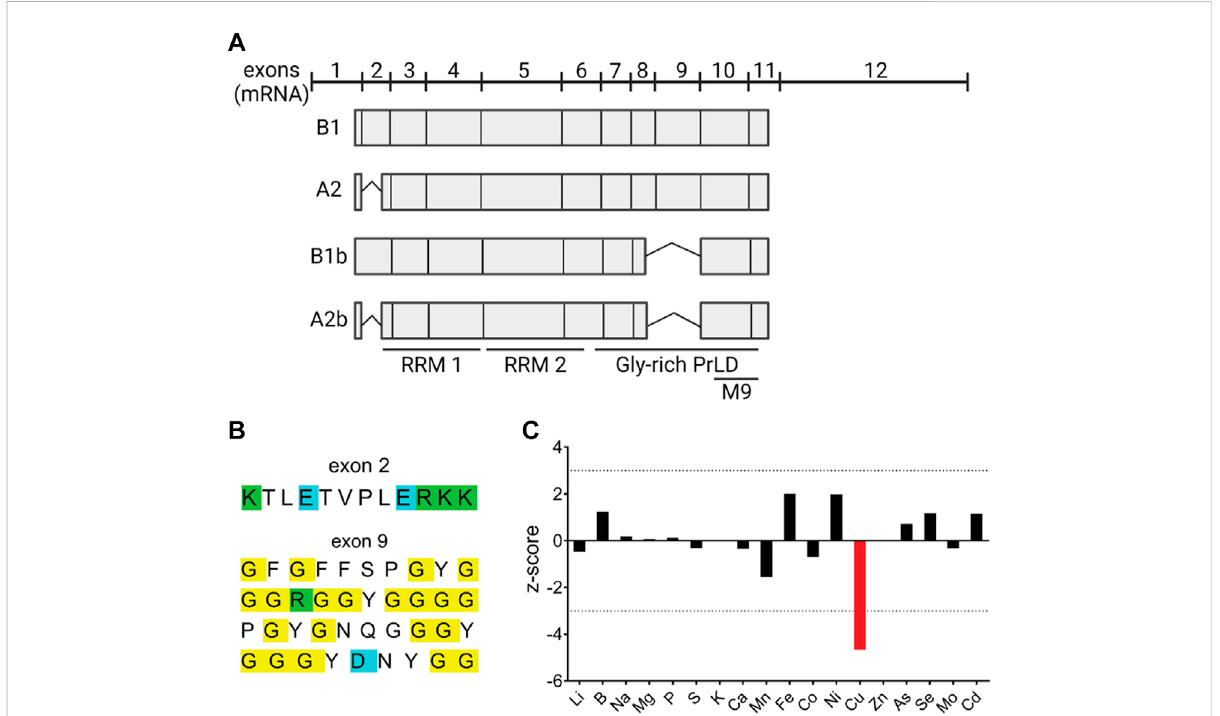
FIGURE 1 RNA-binding protein hnRNPA2/B1 modulates Cu levels in HeLa cells. (A) hnRNPA2/B1 has four distinct isoforms that arise from the alternative splicing of exons 2 and 9. Cartoon representation of the organization of the four hnRNPA2/B1 isoforms at the transcript-level. Exons 2 and 9 are alternatively spliced to generate the four isoforms: B1, A2, B1b, and A2b. Box length is indicative of the relative size of the exon within the transcript. RNArecognitionmotifs(RRMs),glycine-richprionlikedomain(PrLD) (B) Aminoacidsequencesofexons2and9.Positivelychargedaminoacids are indicated in green, negatively charged amino acids in blue, and glycines in yellow. (C) Knockdown of hnRNPA2/B1 in HeLa cells results in a speci fi c and signi fi cant decrease in Cu levels. hnRNPA2/B1 expression was downregulated in HeLa cells via siRNA-mediated knockdown, and inductively coupled plasma mass spectrometry (ICP-MS) was used to measure the abundance of trace metals, including Cu, in these cells. Data are represented graphicallyby plotting thez-score,which indicates thenumber of standard deviations from themean thesignal valuewas basedon the